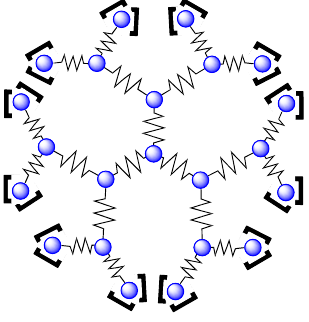
Figure 40. A Ruthenium dendrimer containing twenty-two metal centers [167].